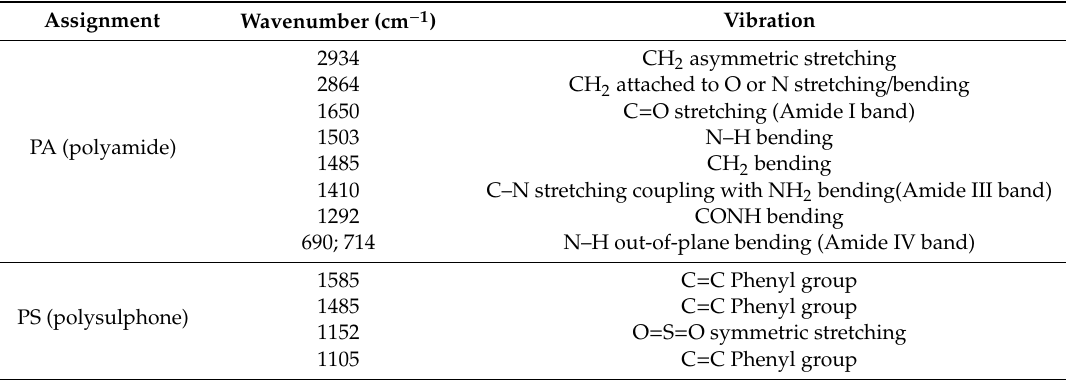
Figure 2. FT-IR spectroscopy for four nanofiltration (NF) membranes at wave number ( a ) from 4000 to 400 cm − 1 ; ( b ) from 1700 to 800 cm − 1 . Table 2. Peak assignment for four NF membranes [25–28].